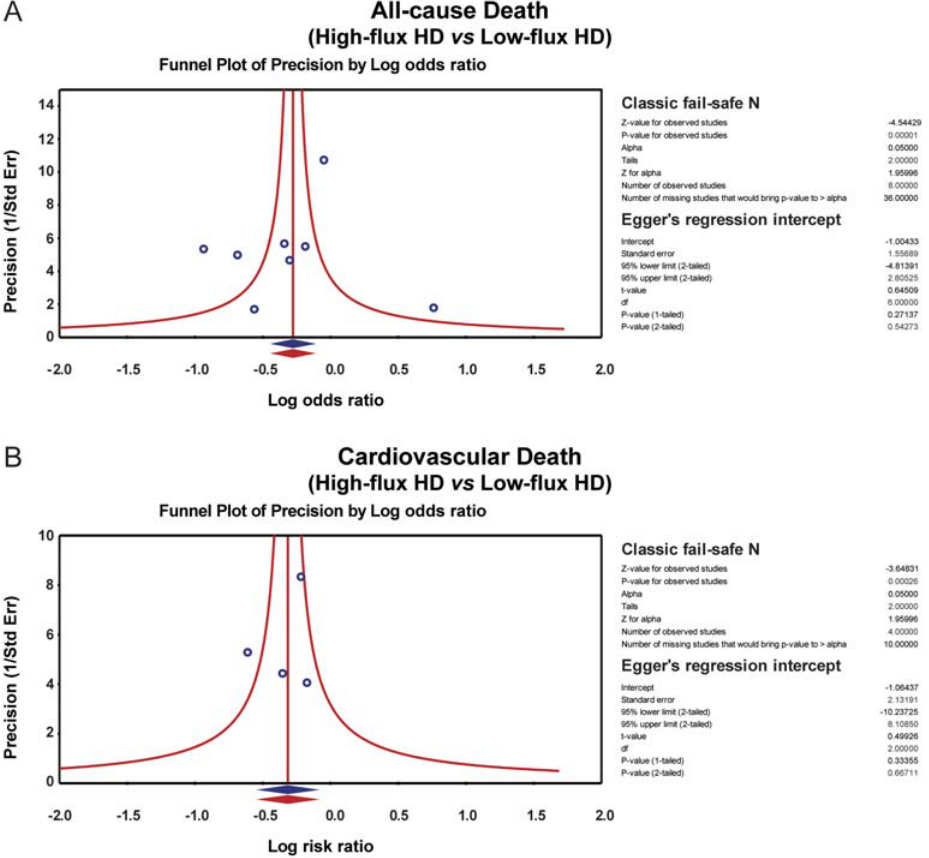
Figure 4. Publication biases of the in fl uence of high- fl ux hemodialysis and low- fl ux hemodialysis on the all-cause death rate and cardiovascular death rate of patients with chronic renal disease. HD: hemodialysis. See Table 1 for reference numbers.